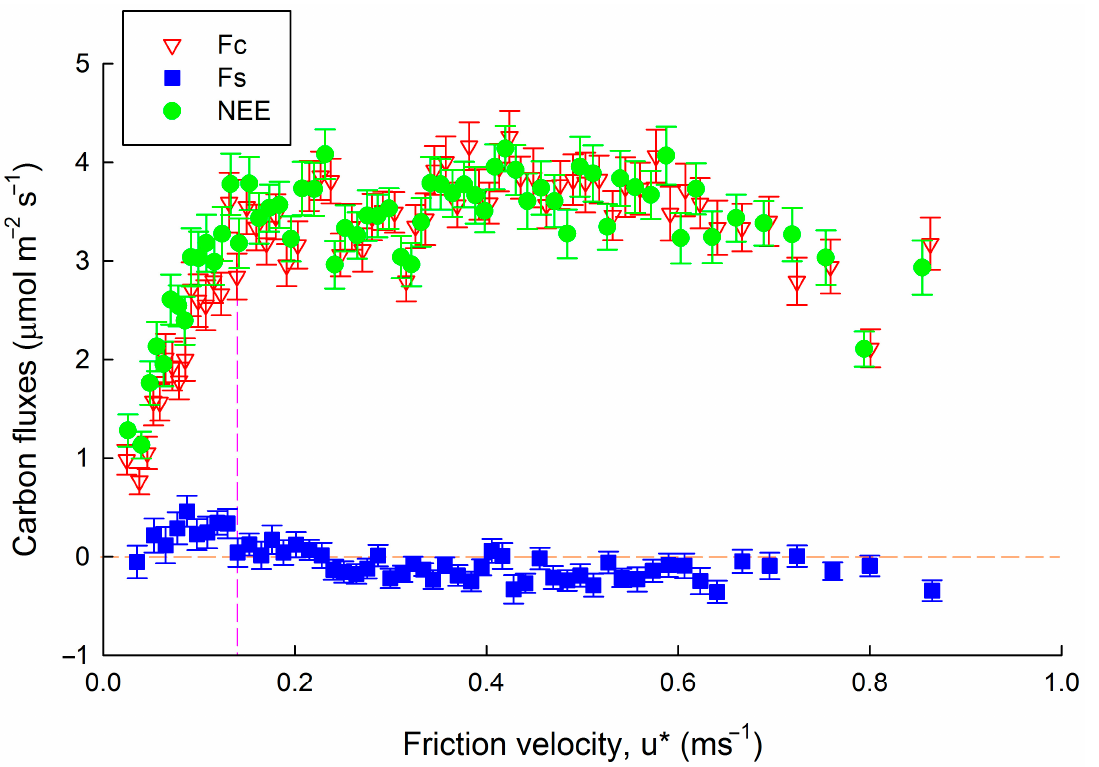
Figure 2. Illustration of nighttime carbon flux (eddy carbon flux ( F c ), storage flux ( F s ) and net ecosystem exchange ( NEE )) underestimation due to stable weather and the determination of the threshold friction velocity ( u *) for filtering. The error bars indicate standard errors.